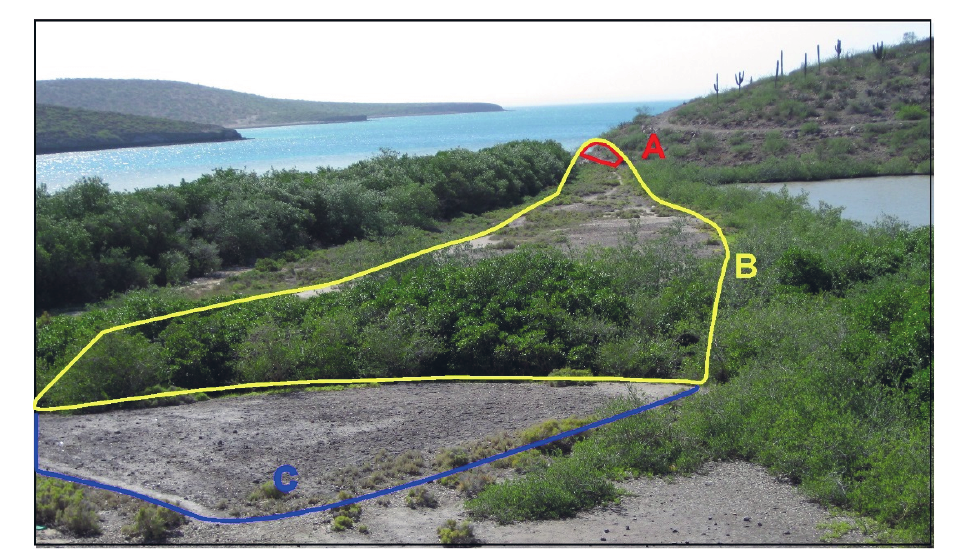
Figure 10. Topography and orientation of the deposited marine material. Looking westward down the inferred path of the marine intrusion. Area A (red) where the largest material was plastered against the hillside is located at the lowest elevation nearest the bay. Mixed sediments, minus the largest terrestrial boulders spread laterally across Areas B (yellow) and C (blue). Steep cliff faces on both sides of the shelly ridge in Area B suggest a narrow path for the wave energy, perhaps due to the angle of approach and the geometry of the projecting hillside. The extension of the reverse of this line leads down the center of the subbay, and eventually towards the city of La